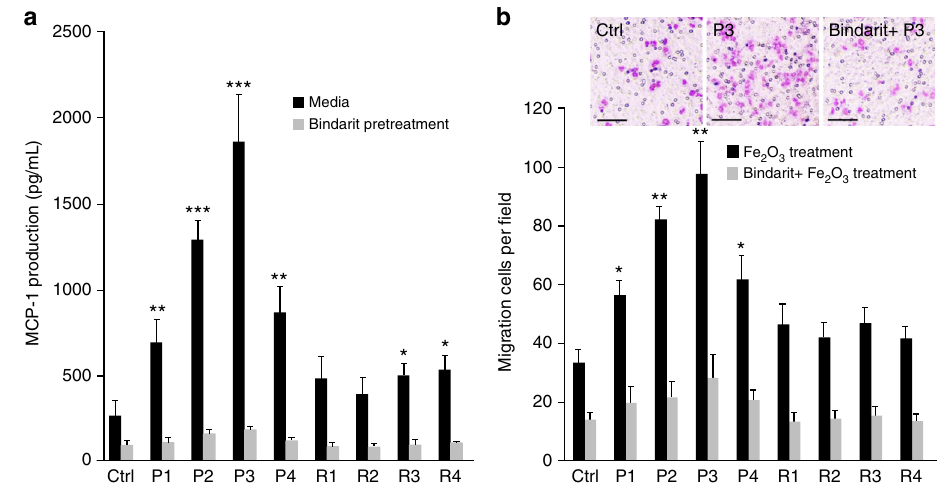
Fig. 5 Effects of Fe 2 O 3 nanoparticles on THP-1 cell migration. a MCP-1 production in the supernatants of Fe 2 O 3 -treated cells and b Transwell migration assays of THP-1 cells. THP-1 cells were pretreated with or without 100 μ M bindarit for 3 h before exposure to 100 μ g/mL Fe 2 O 3 nanoparticles. After 24 h incubation, the supernatants of treated THP-1 cells were collected and divided into two portions. One was used for MCP-1 measurement by ELISA assay and the other one was added into the lower chambers of Transwell systems to incubate with THP-1 cells in upper chamber for 24 h. The migration cells were stained with Diff Quick agent and counted under microscope ( n = 5 images for each treatment). * p < 0.05, ** p < 0.01, *** p < 0.001 compared with ctrl (two-tailed Student ’ s t -test). Scale bar is 50 μ m. Error bar represents SD, n =